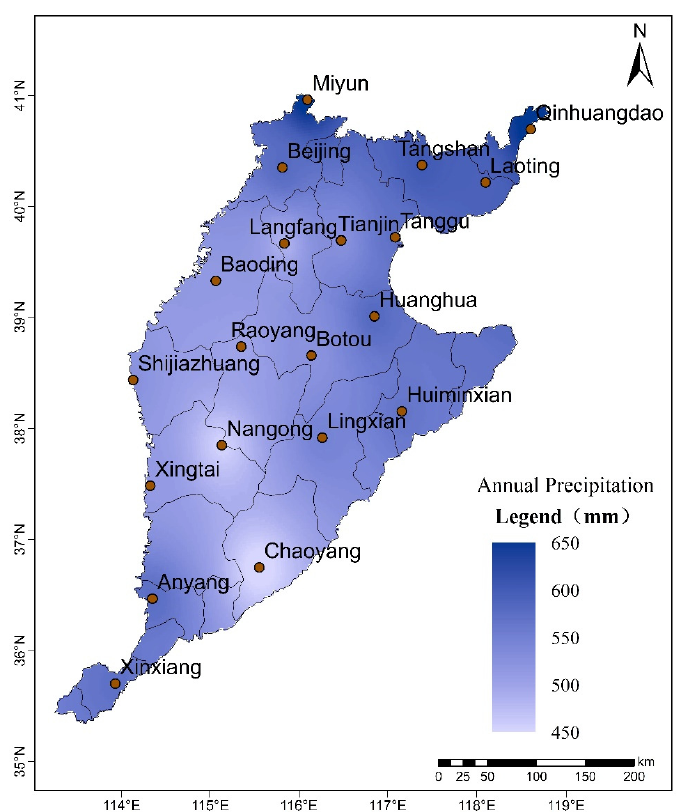
Figure 2. Spatial distribution of annual precipitation in the Haihe Plain. (ArcGIS10.2 was used to draw the spatial distribution map of the average annual precipitation of each station by inverse distance-weighted